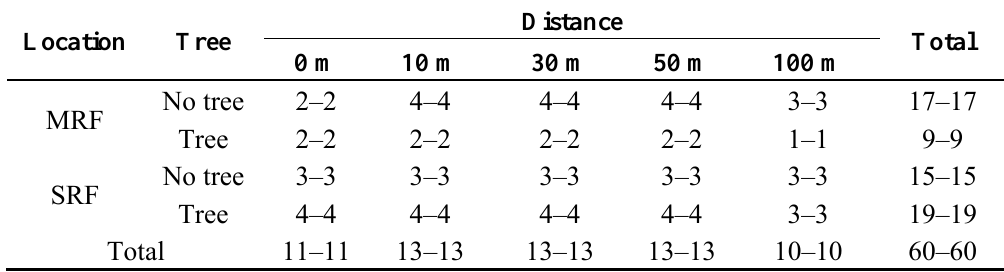
Table 2. Soil-grass sample size distribution by Location × Distance ×